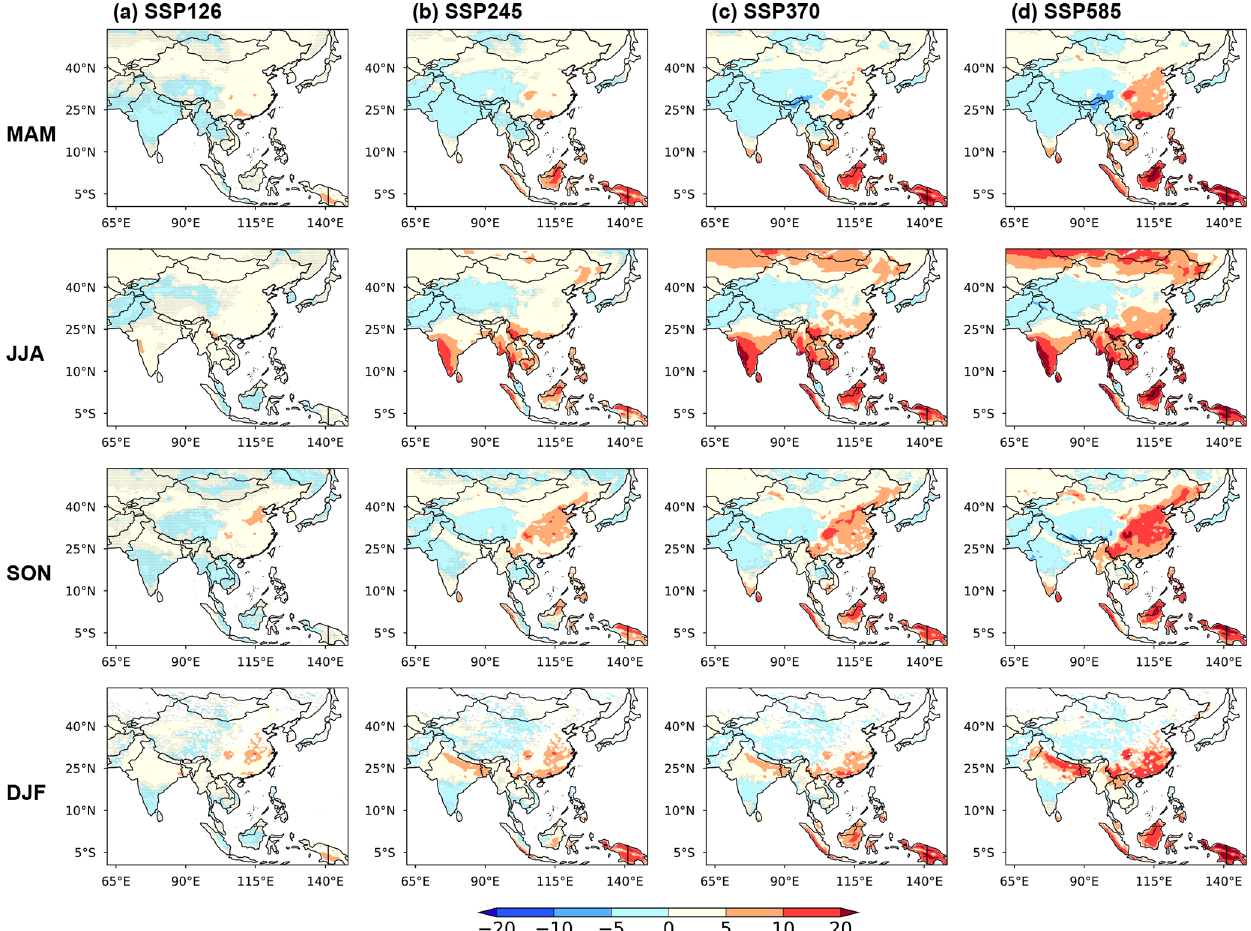
Figure 9. The spatial distributions of percentage differences (%) in near-surface O 3 concentrations between 2025 (2020–2029 mean) and 2095 (2091–2100 mean) driven by climate change under four scenarios (SSP1-2.6, SSP2-4.5, SSP3-7.0, and SSP5-8.5, from left to right) averaged in MAM (March–April–May), JJA (June–July–August), SON (September–October–November), and DJF (December–January– February) (from top to bottom). No overlaying hatch pattern indicates statistical significance with 95% confidence from a two-tailed t